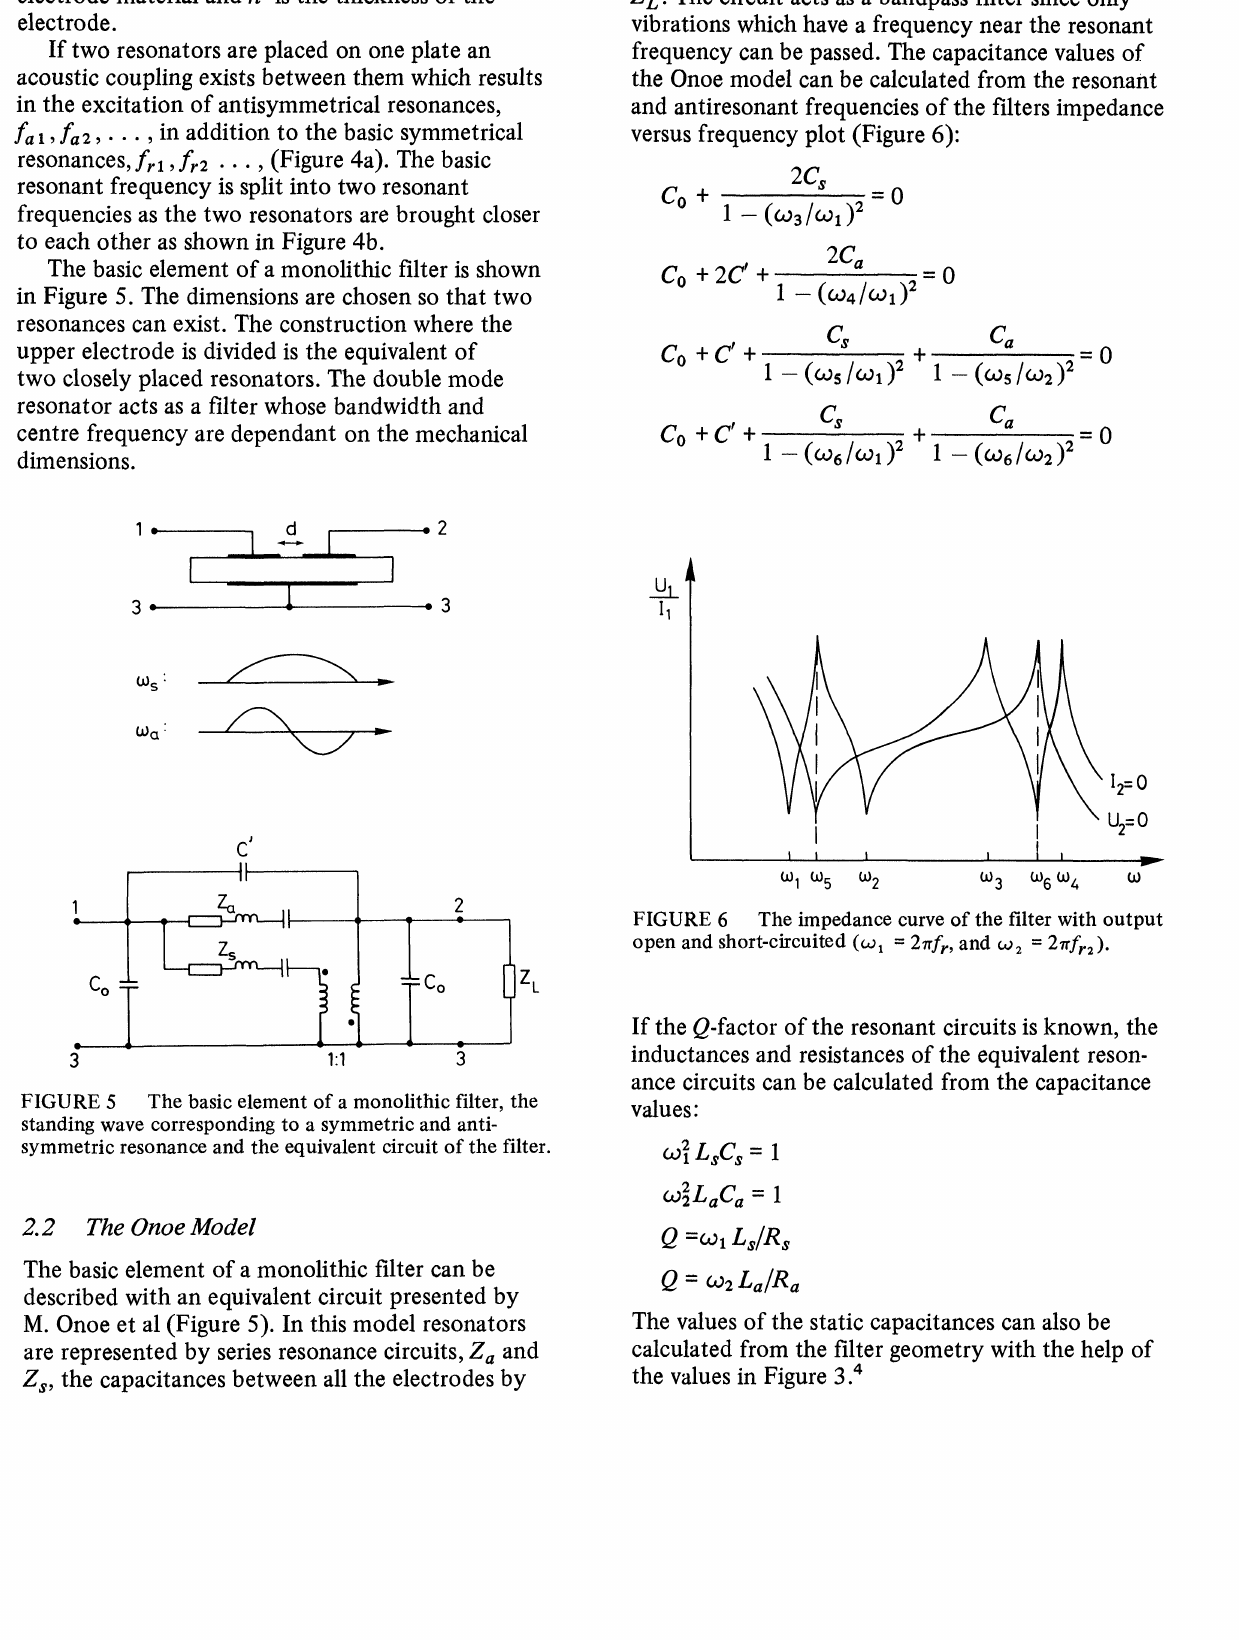
LaIR COu a The values of the static capacitances can also be calculated from the filter geometry with the help of the values in Figure 3.